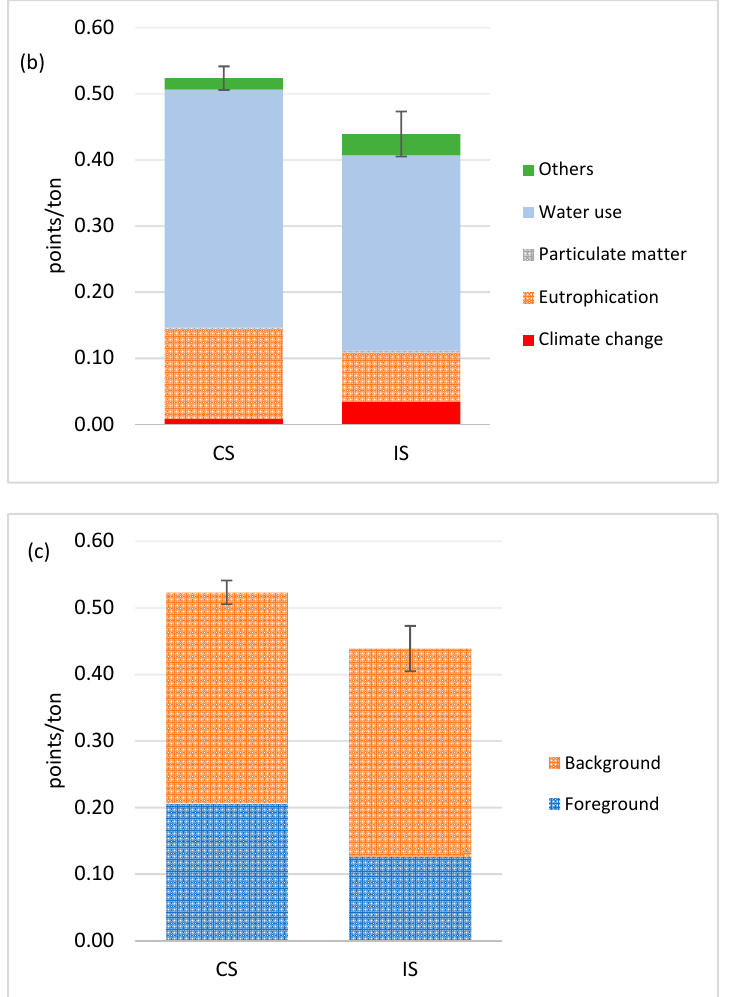
Figure 6. Total environmental impact as a single score at the process ( a ), indicator ( b ), and sub-system ( c ) level for 1 ton of table grapes with conventional (CS) and integrated (IS) system. Monte Carlo standard deviation results are indicated with a black line.